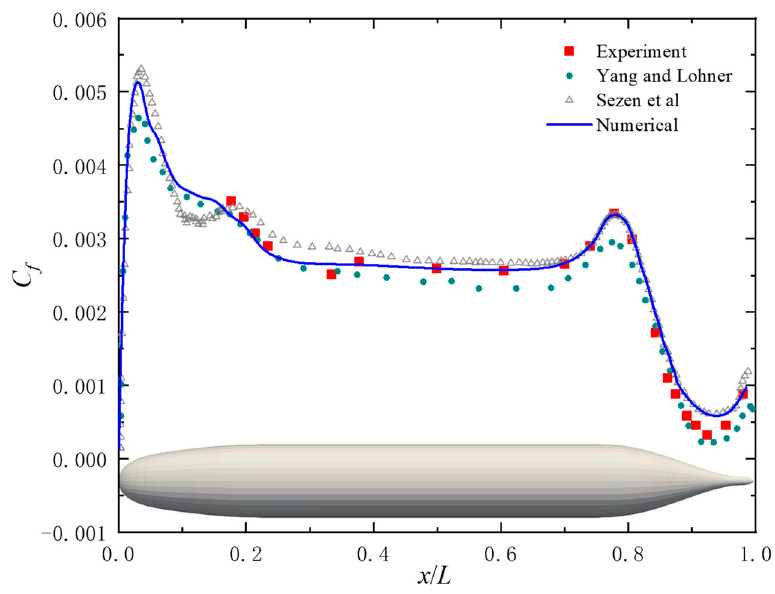
Figure 7. Nondimensional friction coefficient distribution along SUBOFF-AFF-1.